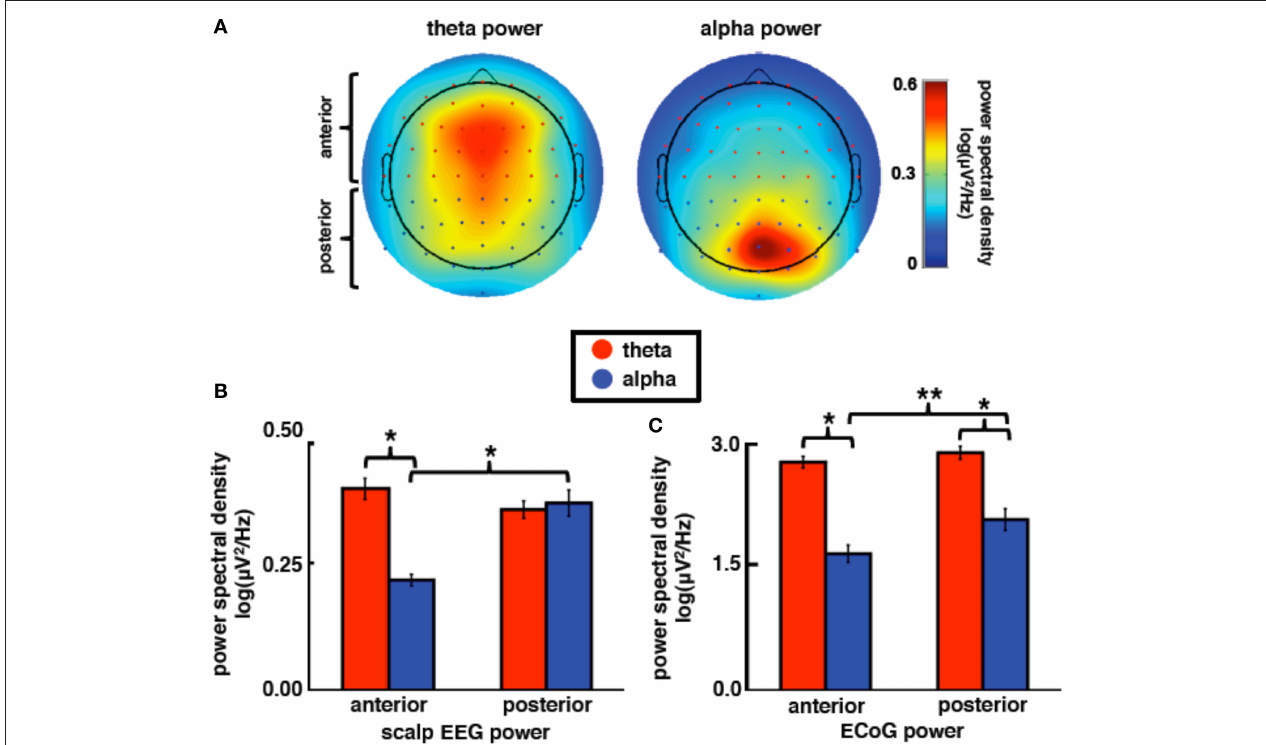
Figure 3 | Theta and alpha power are differentially distributed across the cortex. (A) Scalp topography of average EEG theta and alpha power in 12 young controls performing a visual memory task highlighting the normal topological distribution of band-specific power. (B) Scalp EEG theta power is larger than alpha power at frontal sites whereas alpha power is higher over posterior